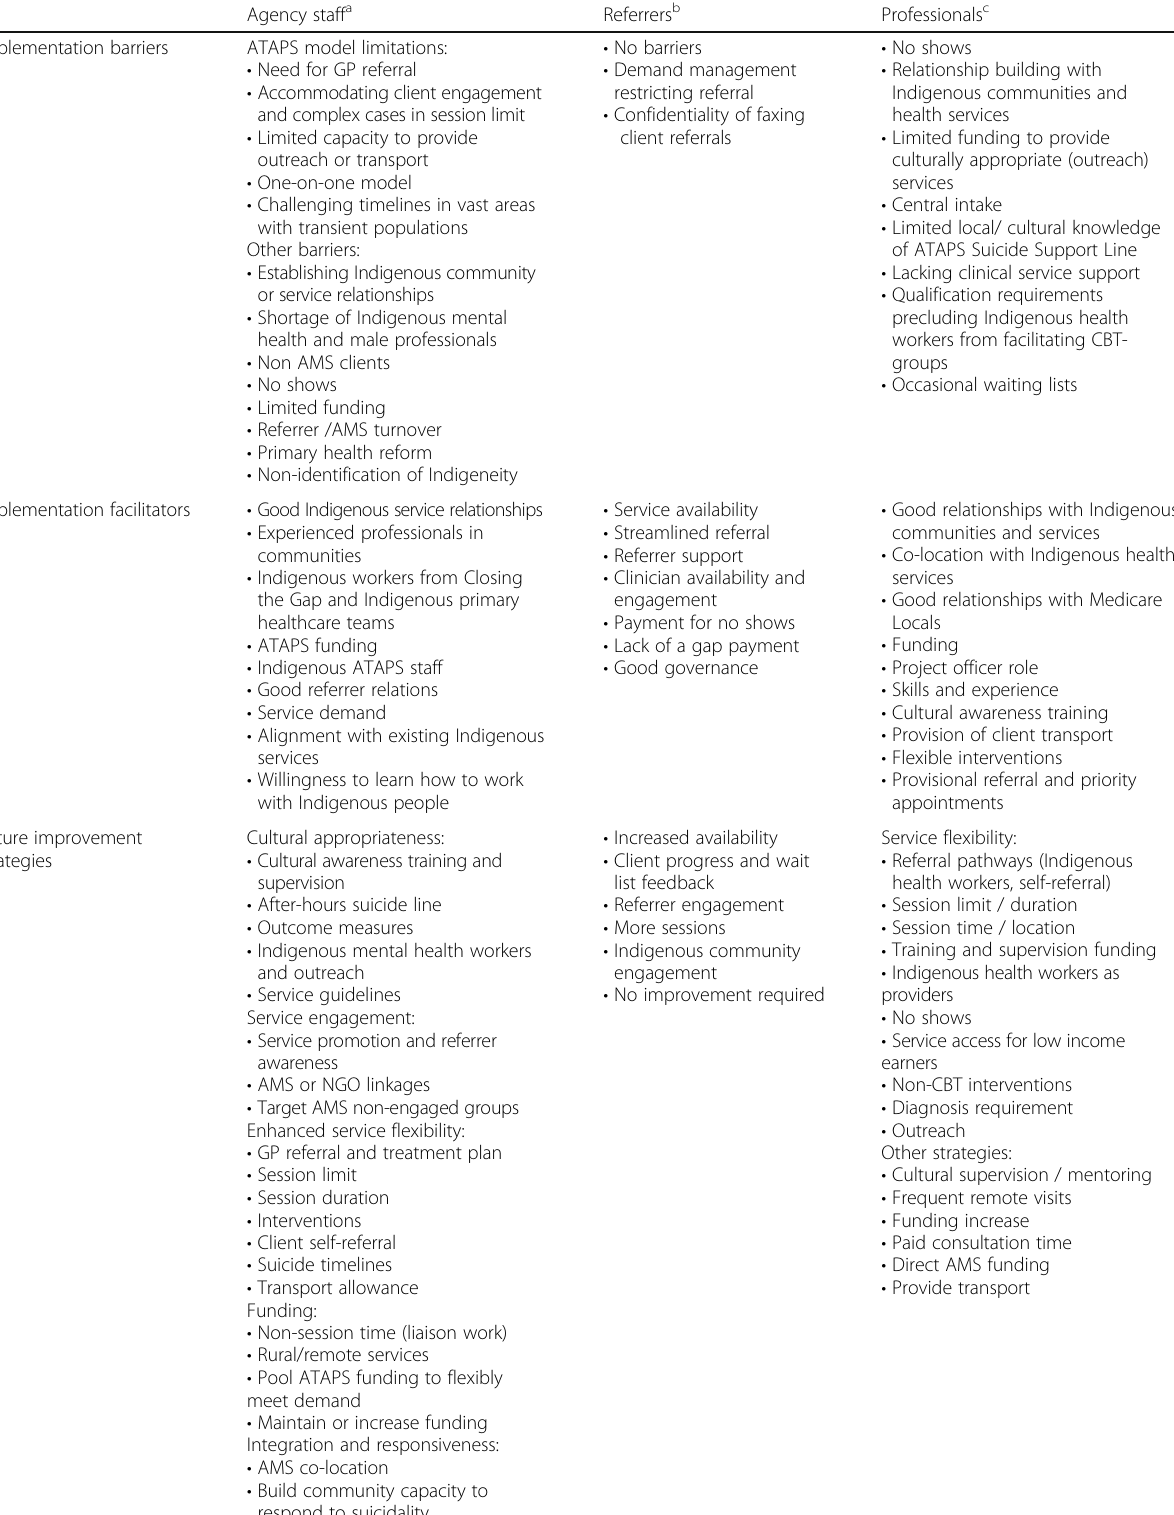
Table 3 Service implementation barriers, facilitators and future improvement strategies Agency staff